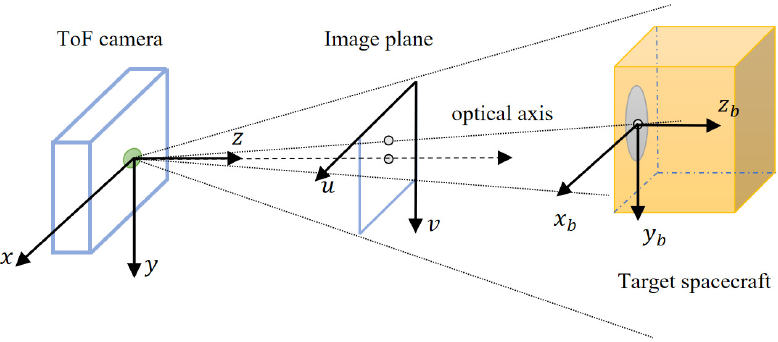
Figure 4. Definition of the coordinate